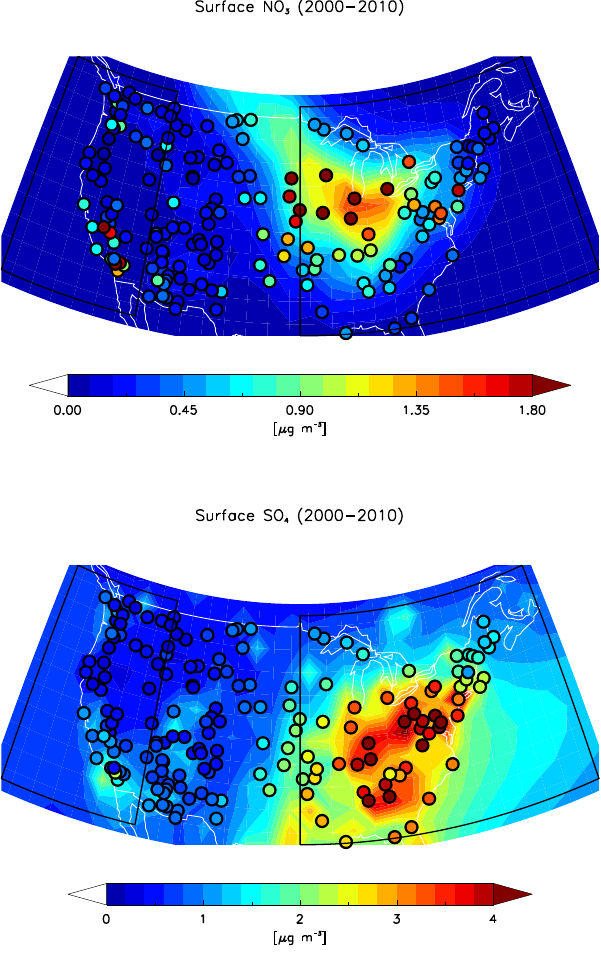
Figure 1. Mean nitrate (upper panel) and sulfate (lower panel) sur- face concentration (2000–2010) simulated by MATRIX-EQSAM overlaid by measurements from the IMPROVE network. The model data units match the units of the measured data (µgm − 3 )